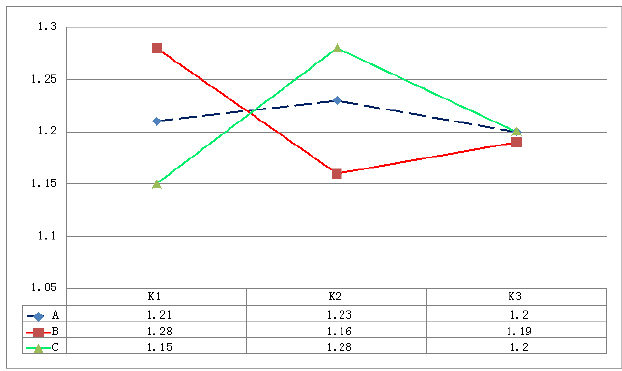
Figure 7: Relationship between factors, levels, and K values (carbon fiber).